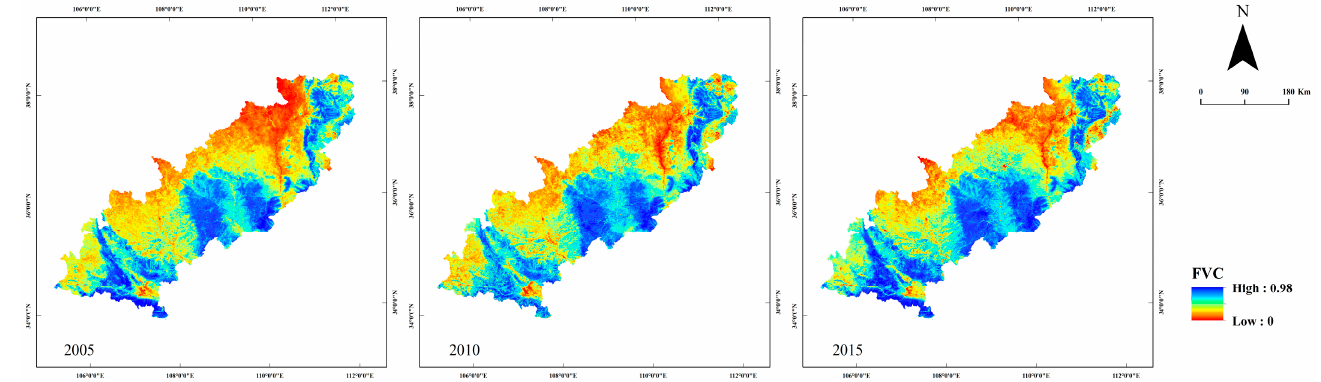
Figure 5. Distribution of vegetation coverage in the Loess Plateau Ecological Screen from 2005 to 2015.